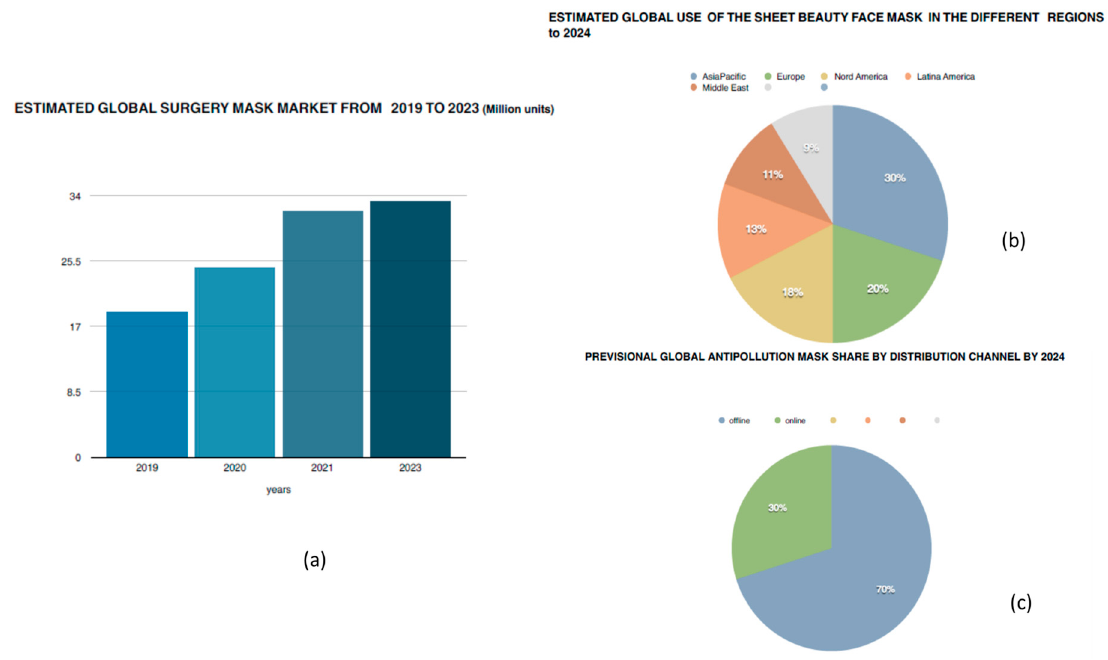
Figure 2. ( a ) The incremental growth of surgical masks [20]. ( b ) Global surgical masks market share by region in 2018. ( c ) Disposable surgery face masks by application: industrial and personal (by courtesy of GranViewResearch